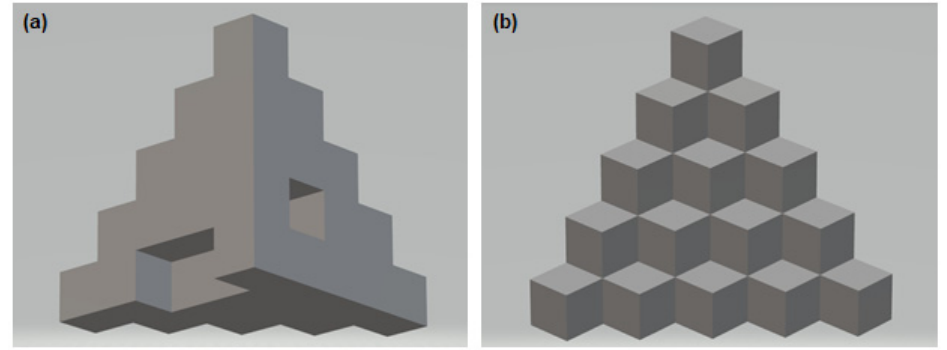
Figure 1. Three-dimensional calibration models ( a ) back, ( b ) front with the following dimensions: object overall x, y, z dimension = 25 mm. Each layer of cubes is 5 mm high. Base layer cutout: 5 mm high, 5 mm deep, 10 mm wide. The 2nd layer cutout: 5 mm high, 5 mm deep, 5 mm wide.